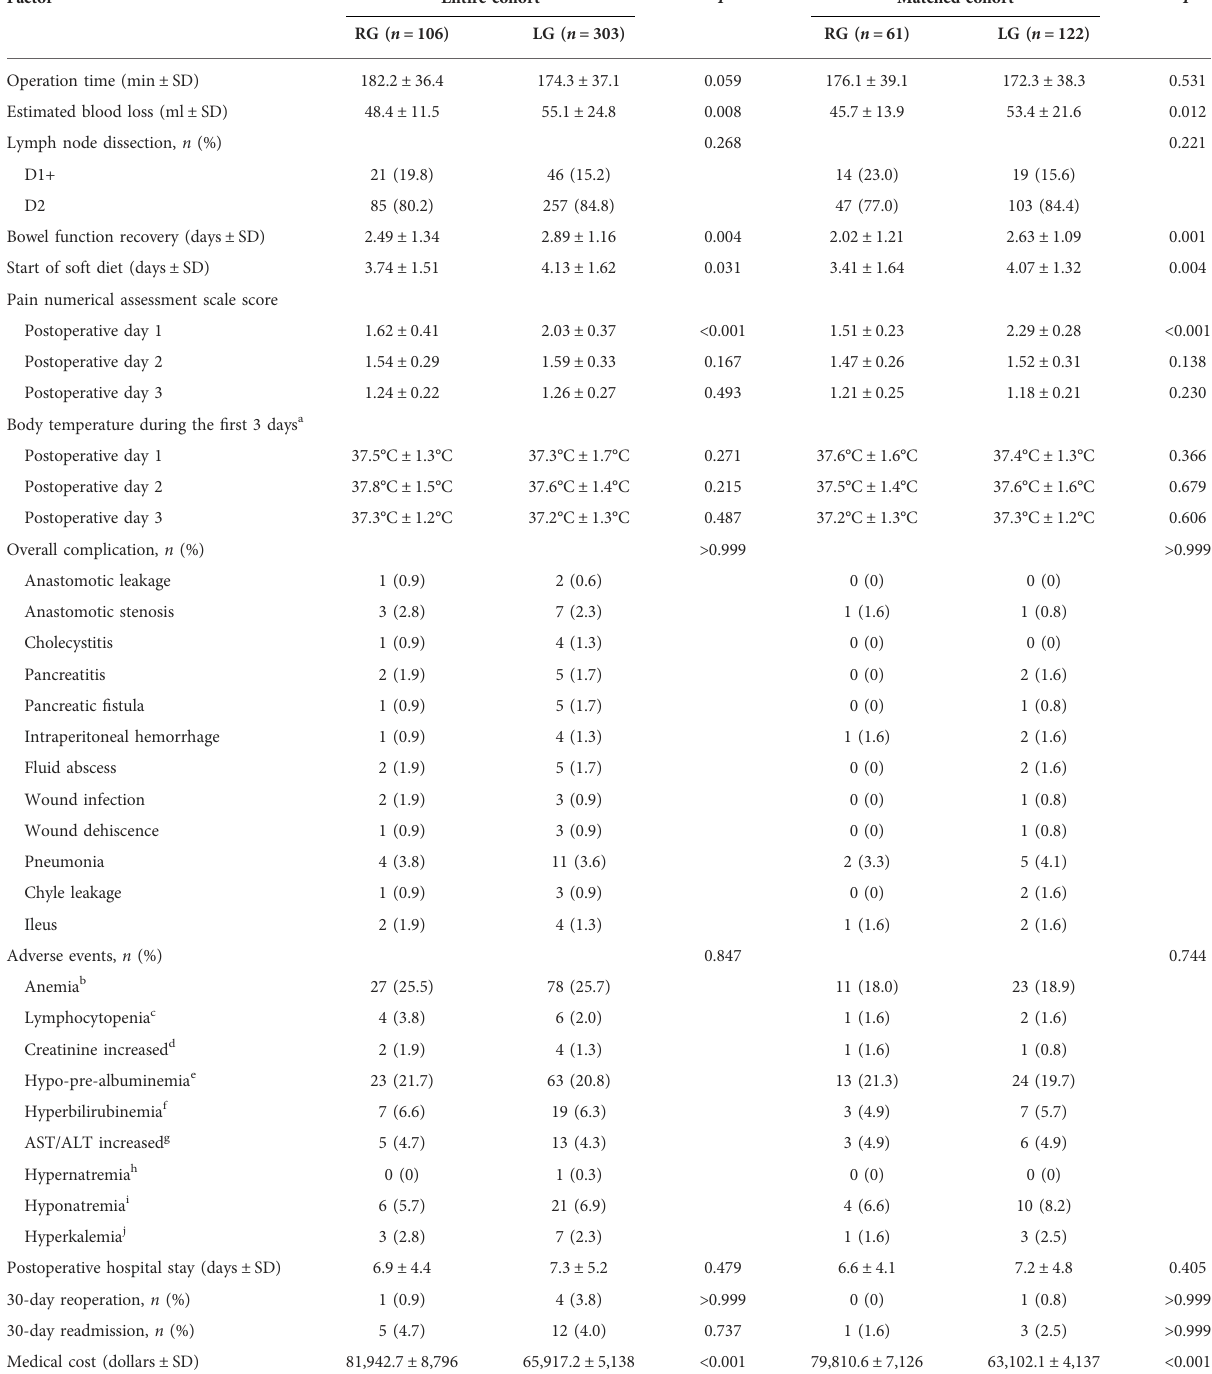
TABLE 2 Operative procedures and surgical